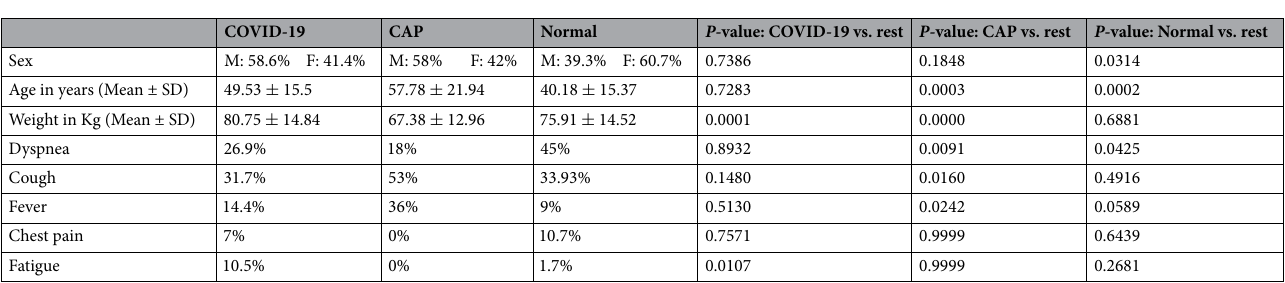
Table 1. Characteristics of the collected dataset and CAP cases adopted from Reference 22 . In total, the study includes 220 patients. SD stands for standard deviation, M stands for male and F stands for